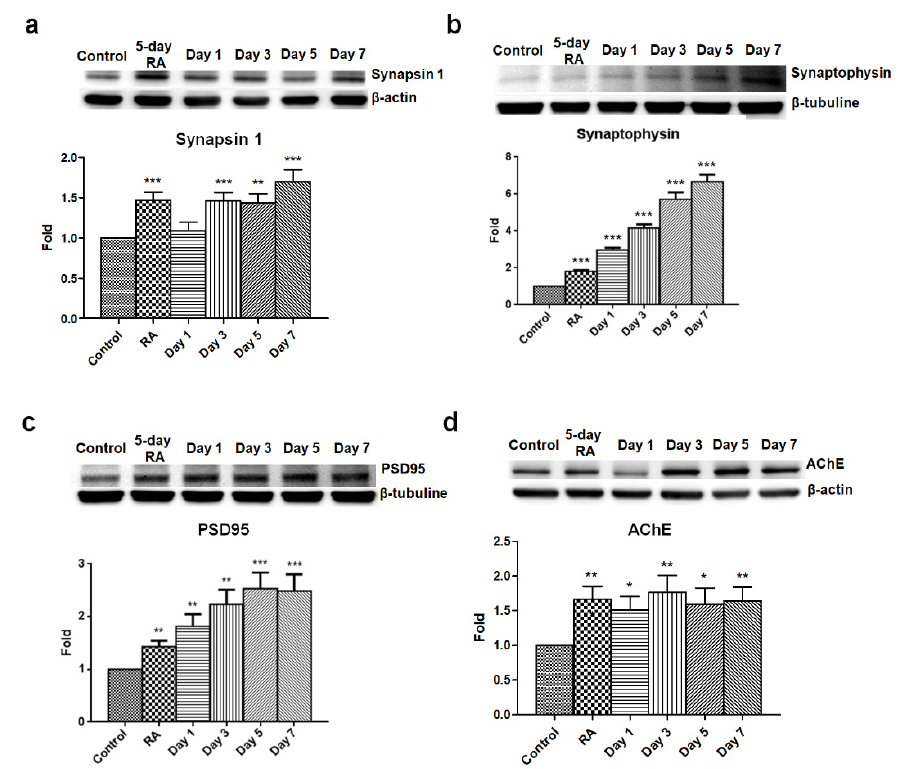
Figure 4. Elevated levels of synapsin 1, synaptophysin, PSD95, and AChE in GLP-1 differentiated SH-SY5Y neurons. Immunoblotting results detecting the expression levels of synapsin 1 ( a ), synaptophysin ( b ), PSD95 postsynaptic density protein 95, ( c ), and AChE acetylcholine esterase ( d )